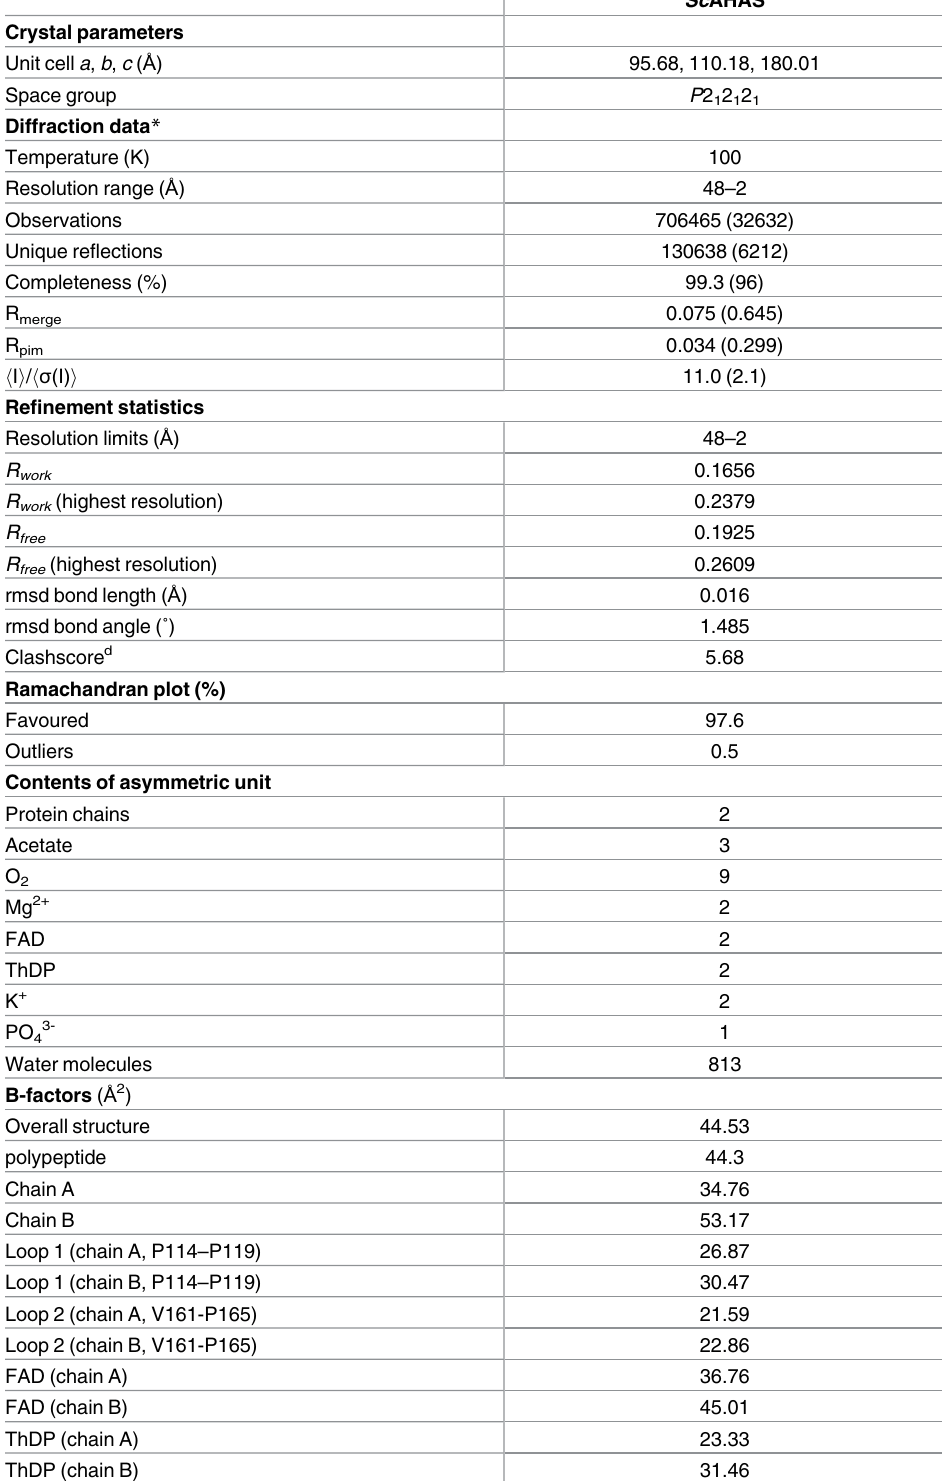
Table 1. Data collection and refinement statistics for Sc